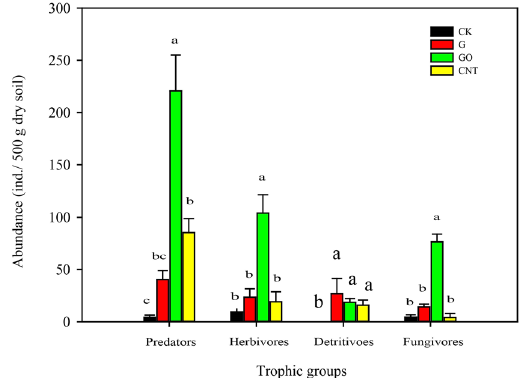
Figure 1. Abundances of four trophic groups of soil microarthropods in the different treatments. Bars represent standard deviation with the mean. Different letters indicate statistically significant differences between treatments, according to the LSD multiple range test ( p < 0.05).